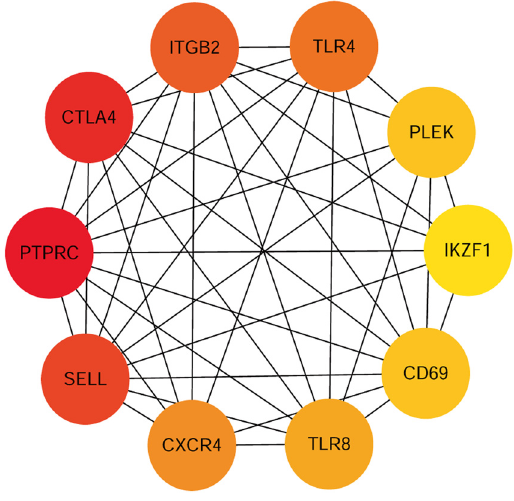
Figure 4: Hub genes in protein – protein interaction network. The top10 hub genes ranked by the degree in the protein – protein interaction network make up a